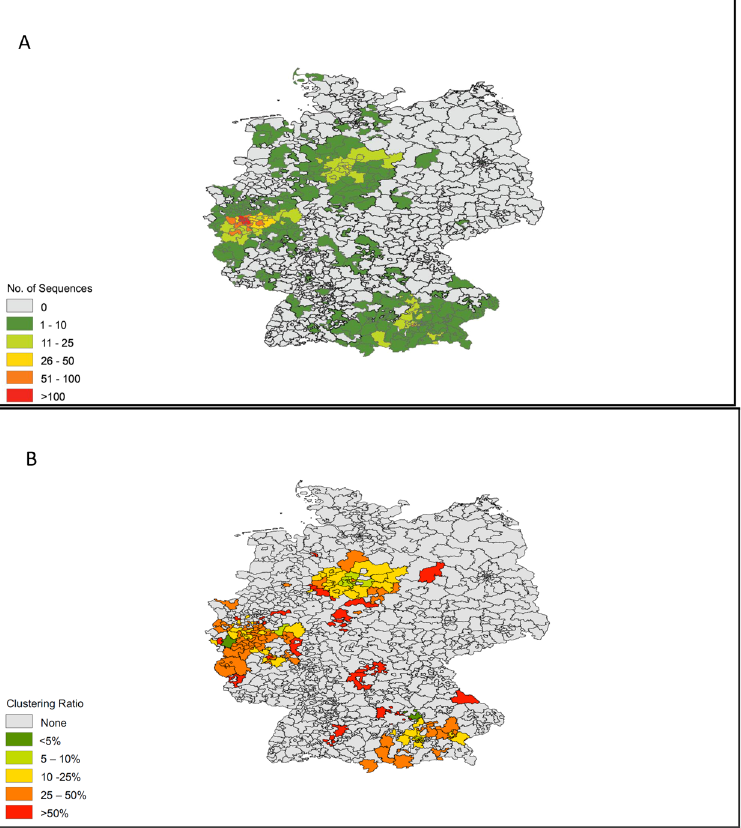
Figure 1. Maps of ( A ) Sampled Population, ( B ) Ratios of Sequences Clustering in each Area. Maps are based on first 3 numbers of zip-codes of residency of reported by